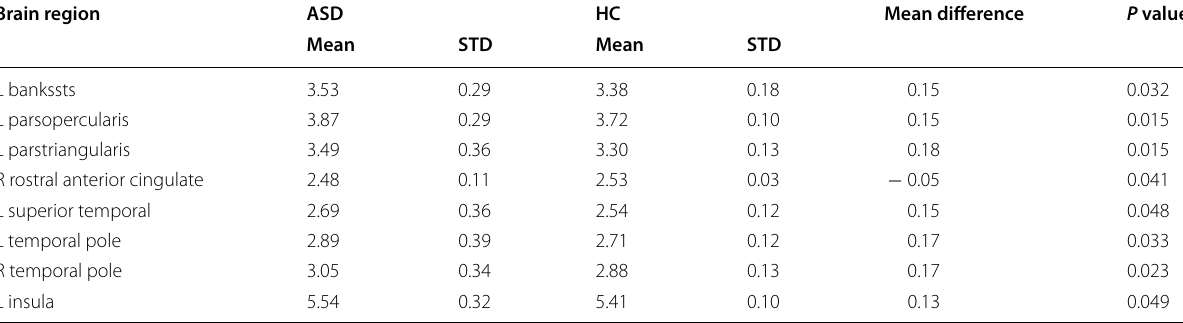
ASD Autism Spectrum Disorder, HC Healthy Controls, STD Standard Deviation, L Left, R Right Table 9 Statistical results of gyrification index parameter in DK Atlas regions (significant differences) Brain